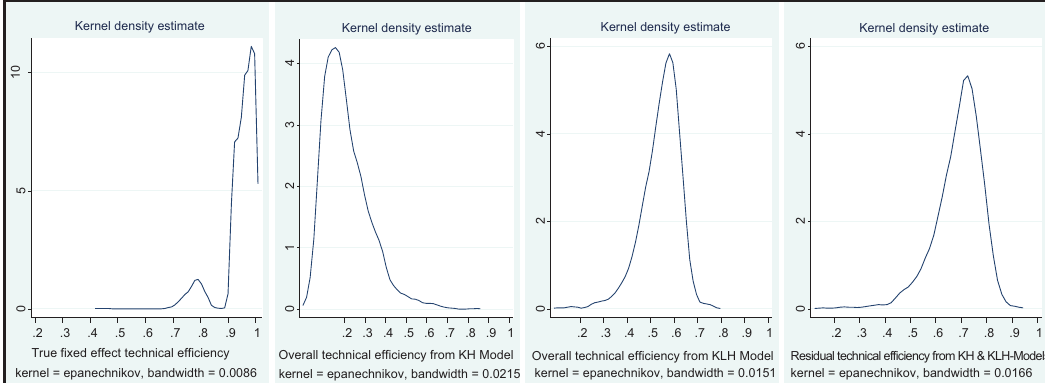
Figure 2 Distribution of transient TE across different models, TFE (overall, left), KH (overall, center left), KLH (center right), and KH and KLH (transient, right).